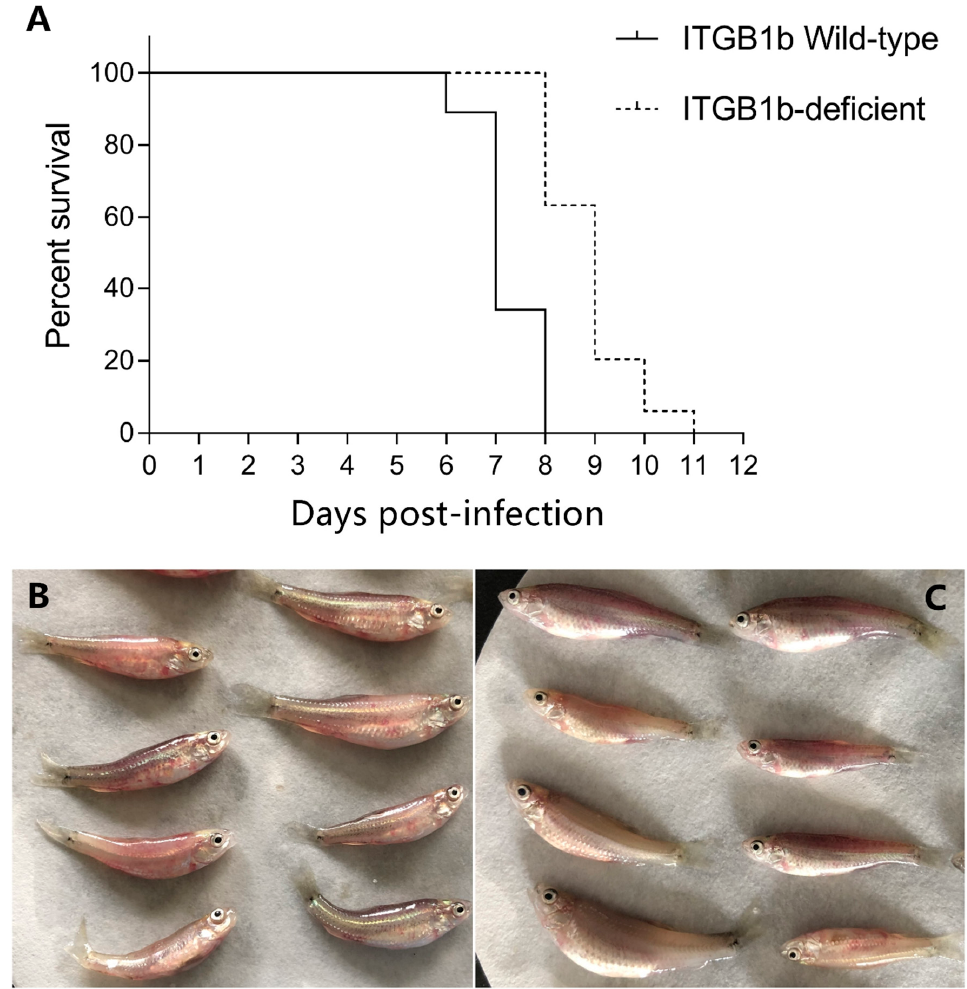
Figure 3. ( A ) Survival curve of ITGB1b-deficient and wild-type rare minnows after grass carp reovirus (GCRV) infection. ITGB1b-deficient and wild-type rare minnows were immersed into GCRV solution for 20 min and transferred to aerated freshwater and cultured at 28 ◦ C. The dead fish in both groups were recorded every day. The clinical symptom of wild-type rare minnows ( B ) and ITGB1b-deficient ( C ) after GCRV infection.